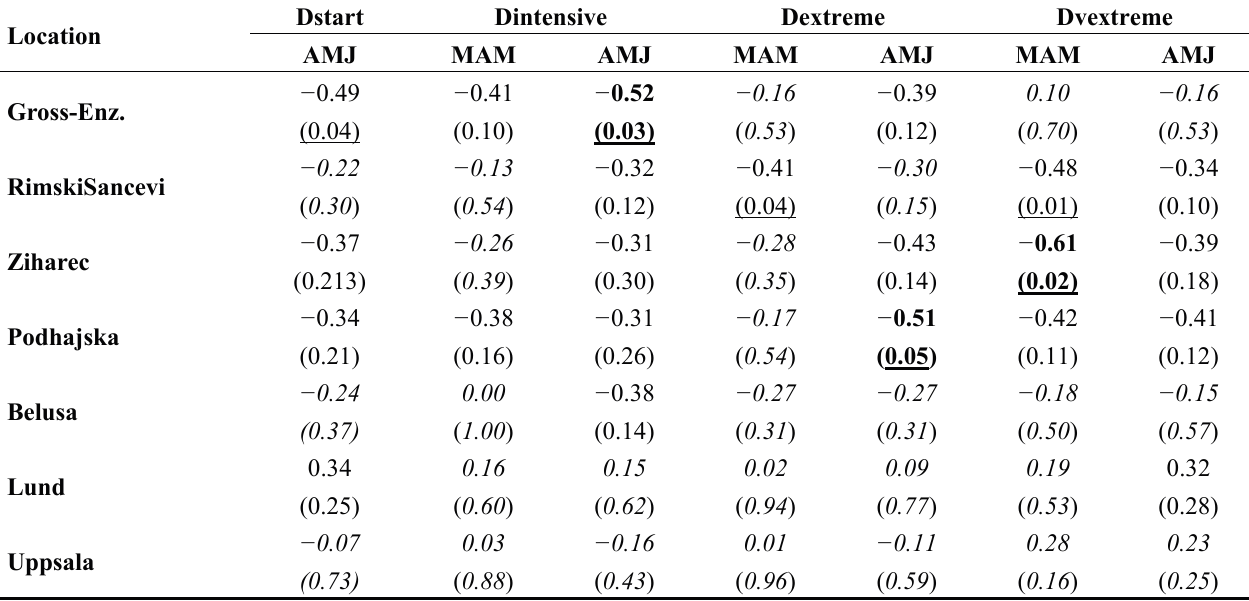
Table 9. Correlation coefficients and p values (in brackets, underlined values are significant) between AMI describing number of dry days and observed WW yield. No effect: 27 of 49 ; with effect: 3 of 49